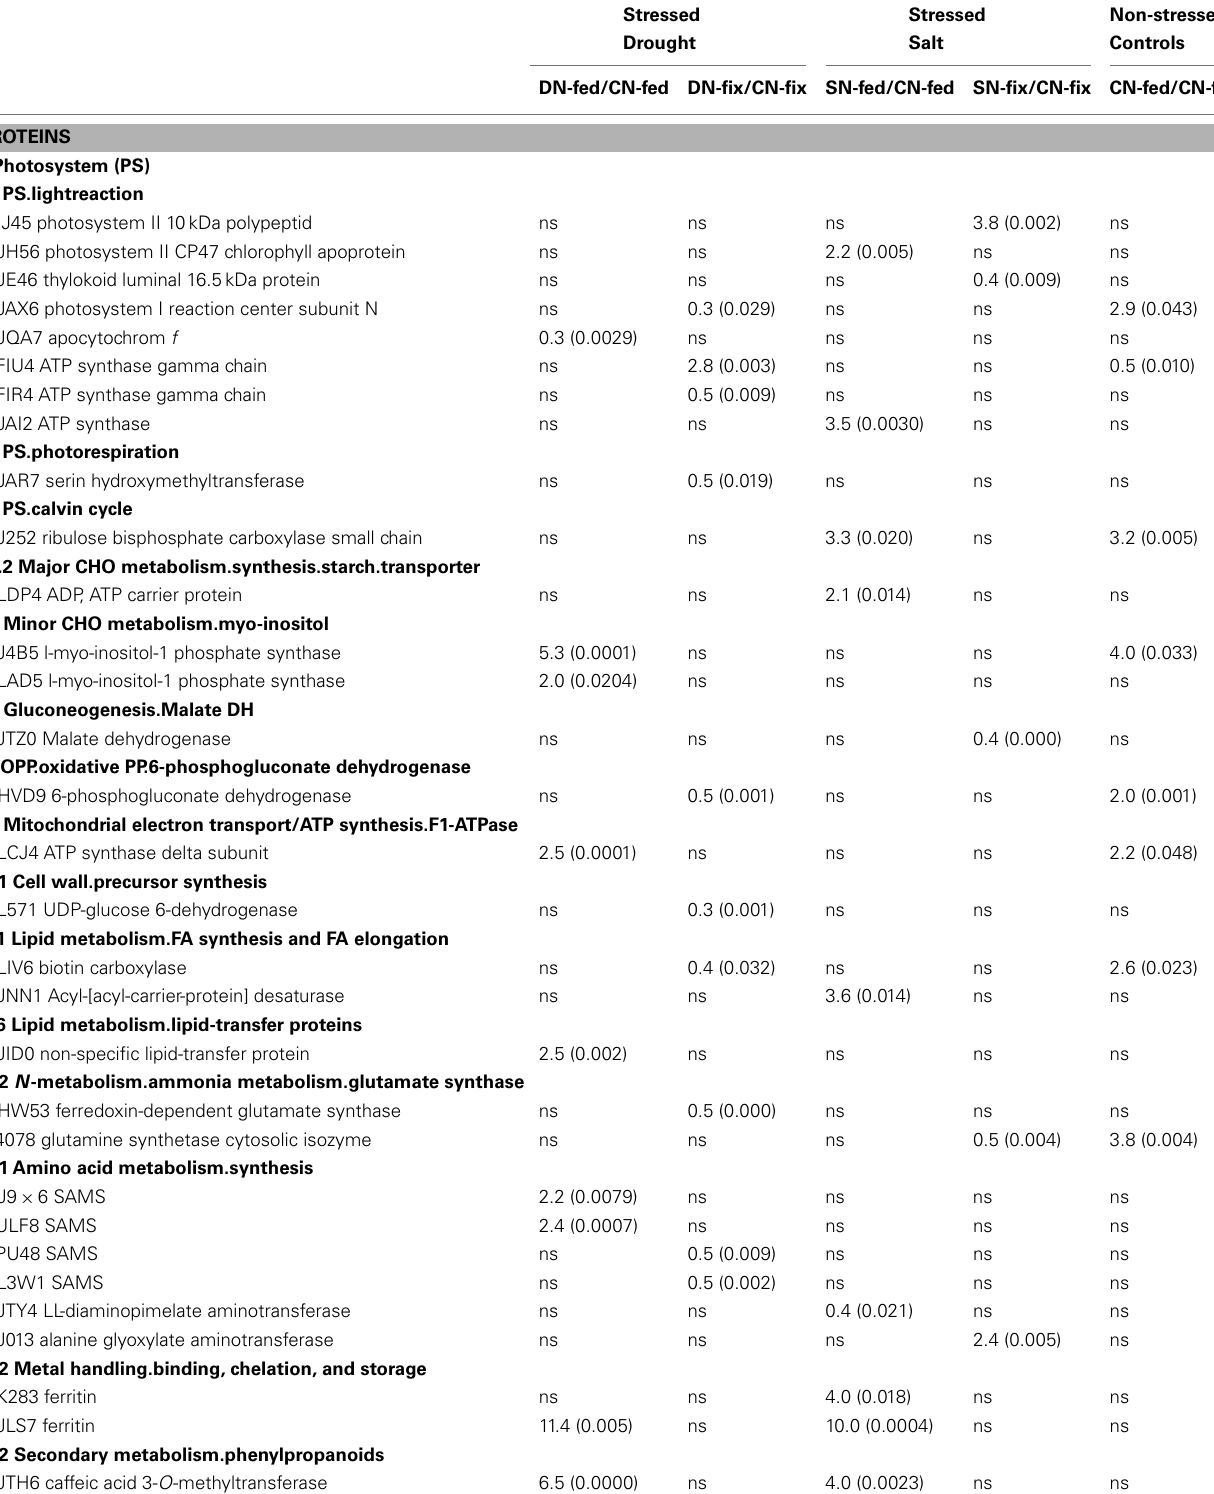
Table 3 | Stress responsive shoot proteins and metabolites of six replicates as fold change.